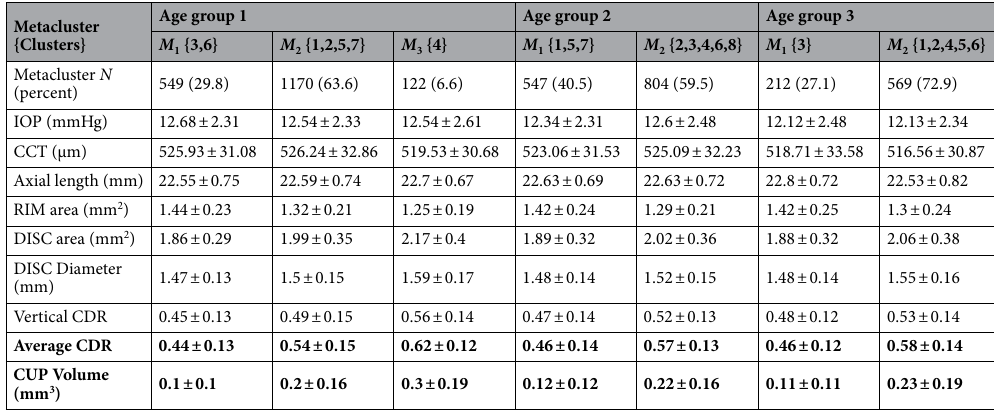
Table 2. The clinical covariates used for metaclustering in the three age groups. The two most significant covariates due to feature selection are shown in bold. The values of each variable in a metacluster are described as mean ± sd. The units are given in parentheses. N the number of samples, IOP intraocular pressure, CCT central corneal thickness, CDR cup-to-disc ratio, sd standard